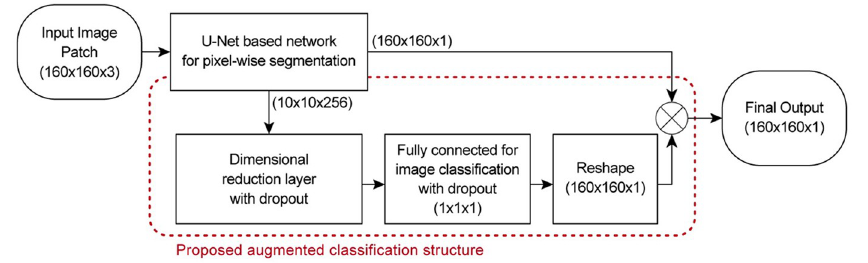
Fig 7. Block diagram of the proposed network with augmented classification structure.